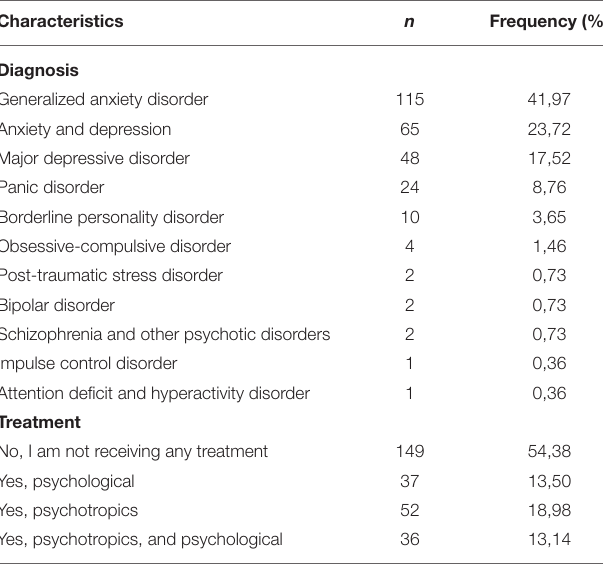
TABLE 1 | Socio-demographic characteristics of the sample ( N = 2,206). TABLE 2 | Mental health of participants: subjects reporting preexisting mental disorders ( n = 274).